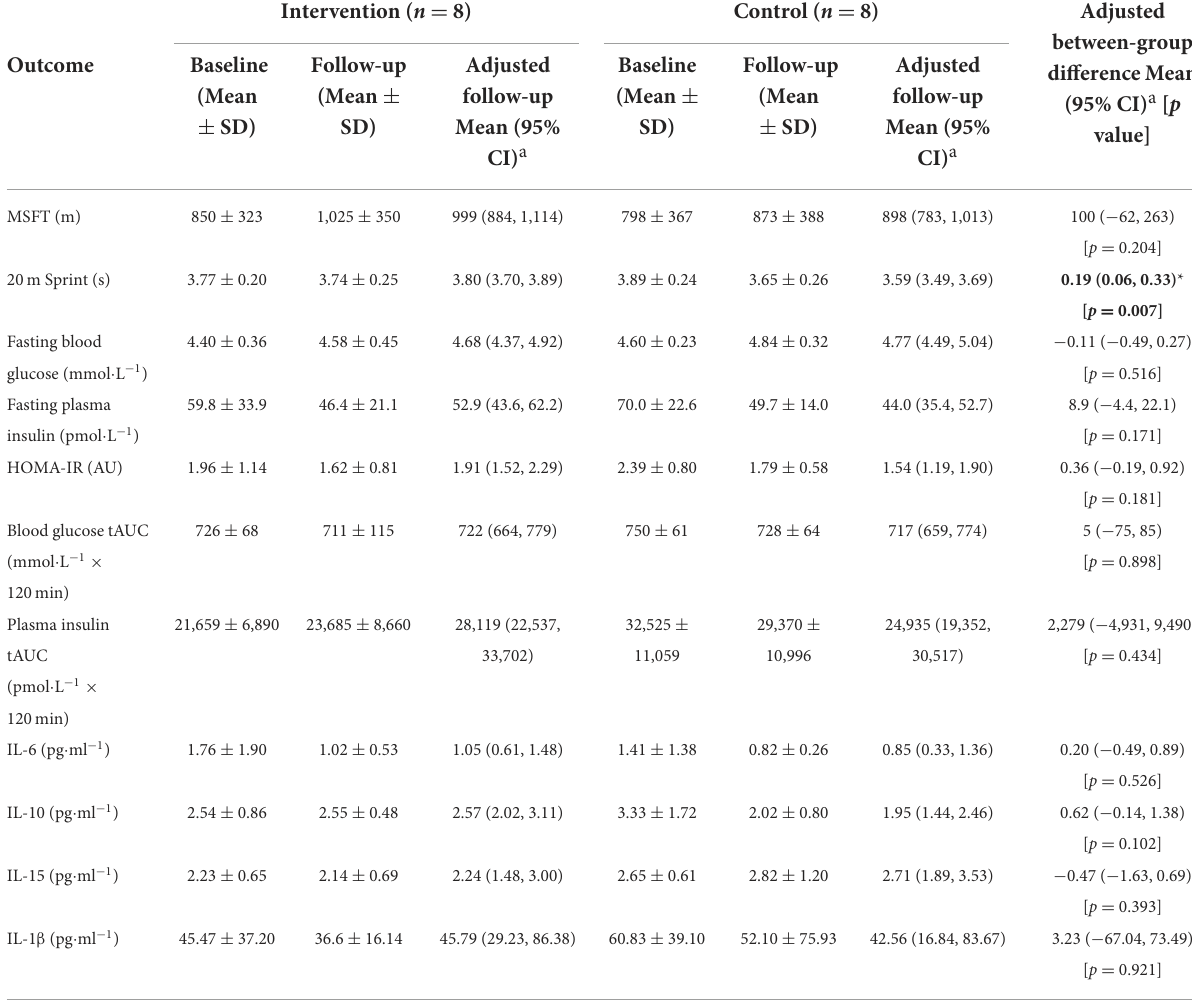
TABLE 4 Baseline and follow-up results of physical fitness and cardiometabolic health outcomes, with data presented as mean ± SD. Intervention ( n =